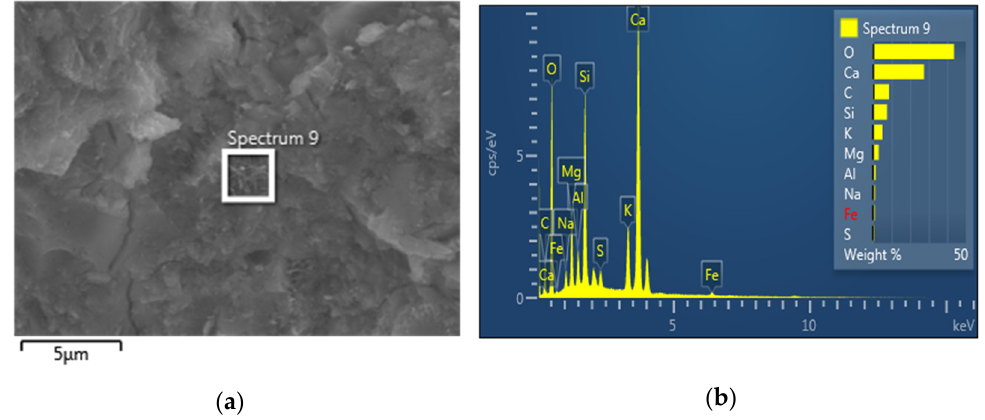
Figure 12. EDS results of cement paste containing TEOS/PVP NFs: ( a ) SEM image; ( b ) EDS spectrum—focus on nanofibers zone.